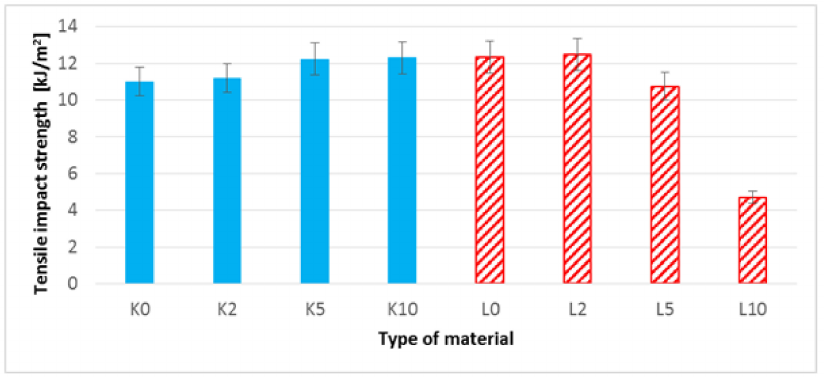
Figure 15. Impact tensile strength of biocomposites filled with hemp and flax fibers before and after surface modification.